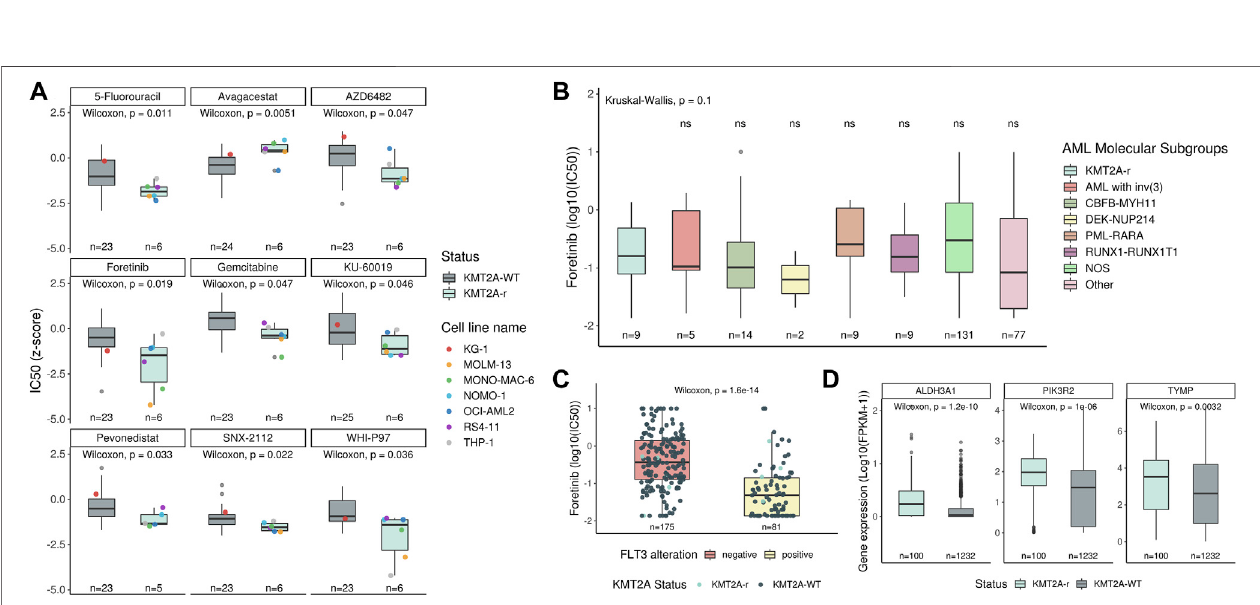
FIGURE 4 | Identi fi cation of therapeutic drugs for KMT2A -r leukemia. (A) Comparison of the IC50 data, available in the GDSC database, toseveral drugs between KMT2A -WT and KMT2A -r leukemia cell lines. The KG-1 (red point) isa human AML cell line, with a variant, KG-1a, known to be resistantto chemotherapy. Comparison of the sensitivity to foretinib between (B) AML molecular subgroups and KMT2A -r, as well as (C) FLT3 wild-type (red boxplot) and FLT3 mutated (yellow boxplot). (D) Transcript expression compared between KMT2A -WT and KMT2A -r in acute leukemia samples included in this study.